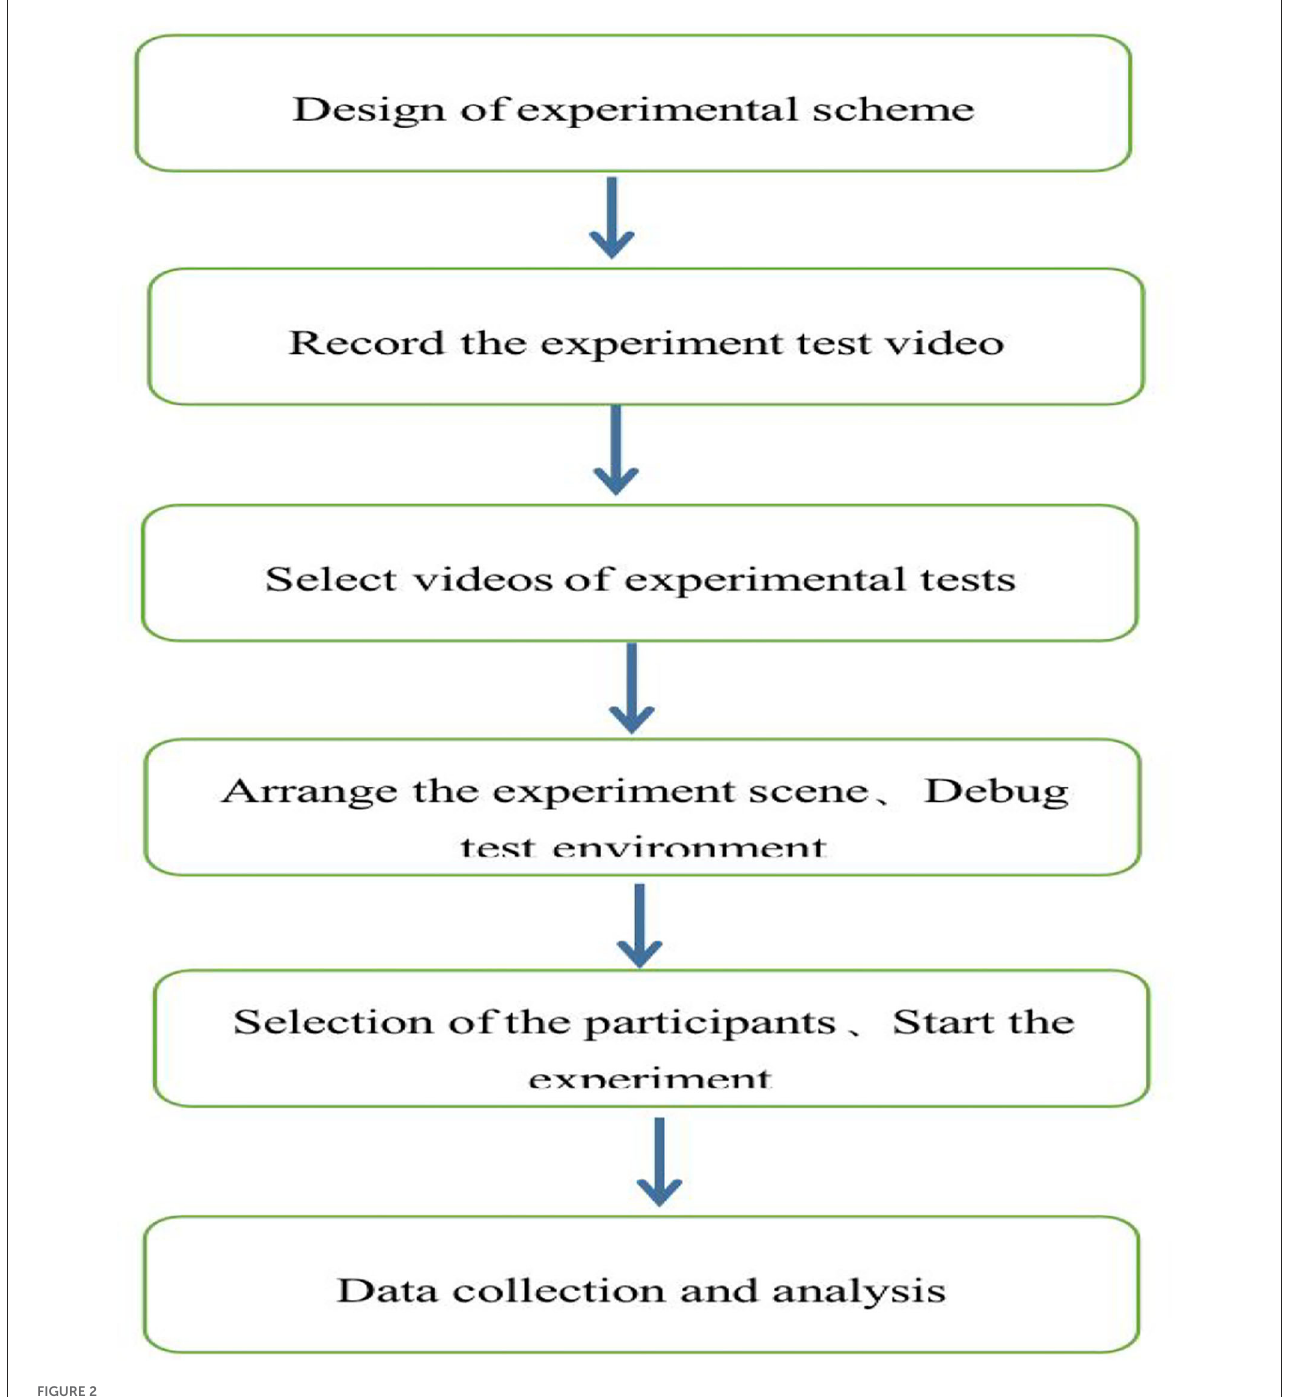
FIGURE2 A schematic diagram of the experimental